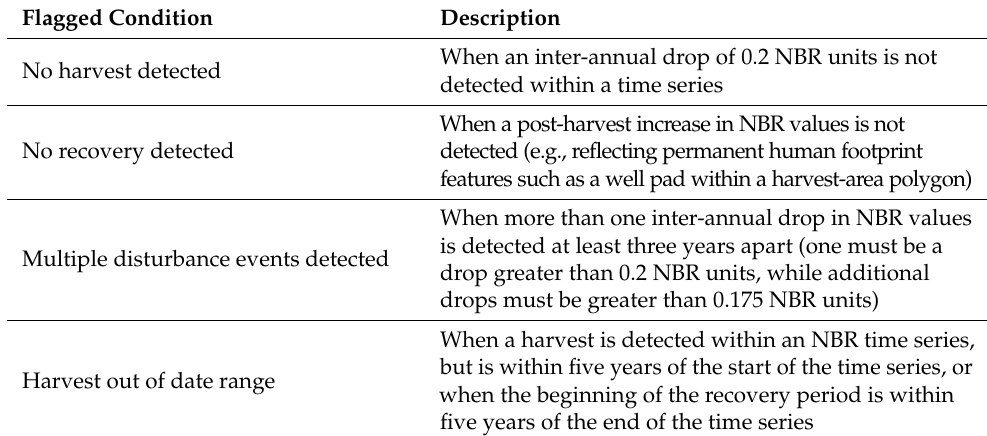
Table 1. Description of the conditions under which pixels are flagged and removed from further analyses, and the final